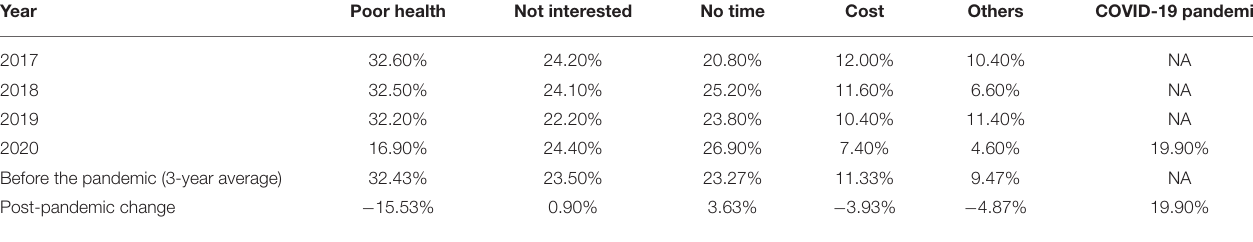
TABLE 6 | Reasons for not participating in tourism.